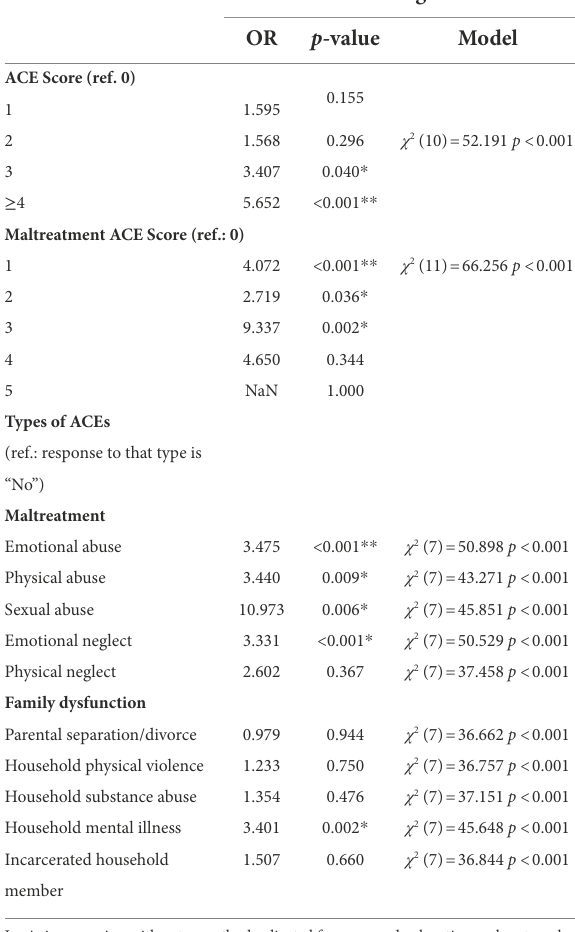
TABLE 3 Adjusted odds ratios for overall risk for eating disorders by the total number of adverse childhood experiences (ACEs) and forms of maltreatment, and by presence of a type of ACE.